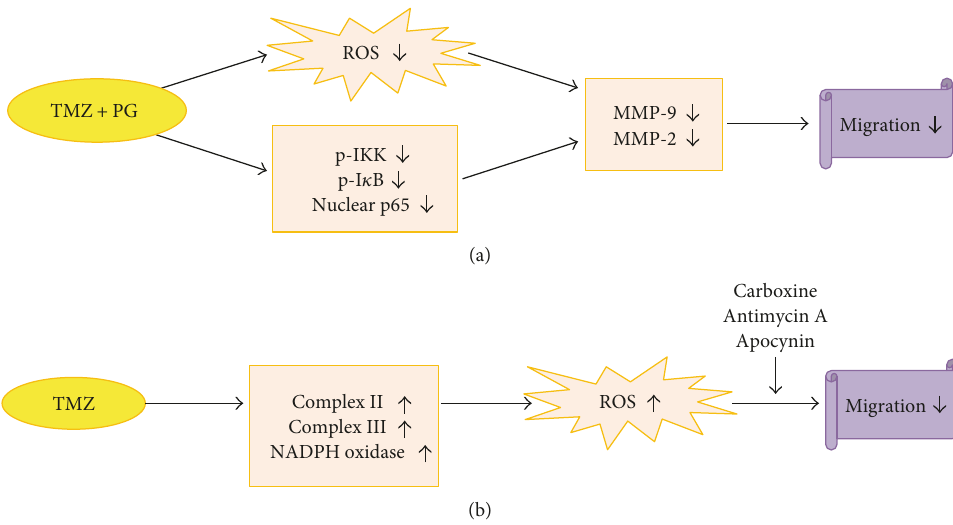
Figure 8: Diagrammatic scheme denoting the cascade of events in antimigration. (a) PG enhances the e ff ect of TMZ on antimigration through inhibition of ROS generation, the NF- κ B pathway, and MMP activities; (b) inhibition of mitochondrial complex II, III, and NADPH oxidase contributes to the antimigration e ff ect of